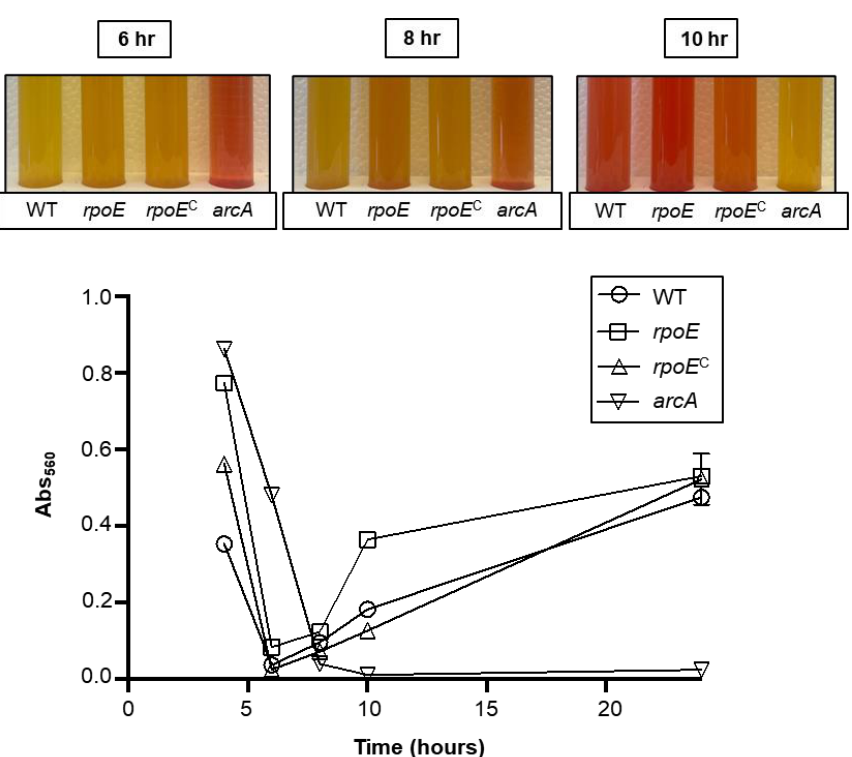
Figure 6. Mutation of rpoE enhances the rate of the deacidification of the extracellular media. Wild type (WT), the rpoE mutant ( rpoE ), its complemented variant ( rpoE C ), or an arcA mutant ( arcA ) cultures were standardized to a starting OD 600 = 0.05 and were grown in THY supplemented with phenol red (18 µg mL −1 ) and supplemental arginine (30 mM). Time points were established based on preliminary studies. Color changes ( top ) and absorbance changes ( bottom ) in media pH over time are shown above. The absorbance of spent media was measured at 560 nm (Abs 560 ) at the indicated time points. Each experiment is representative of three biological replicates.